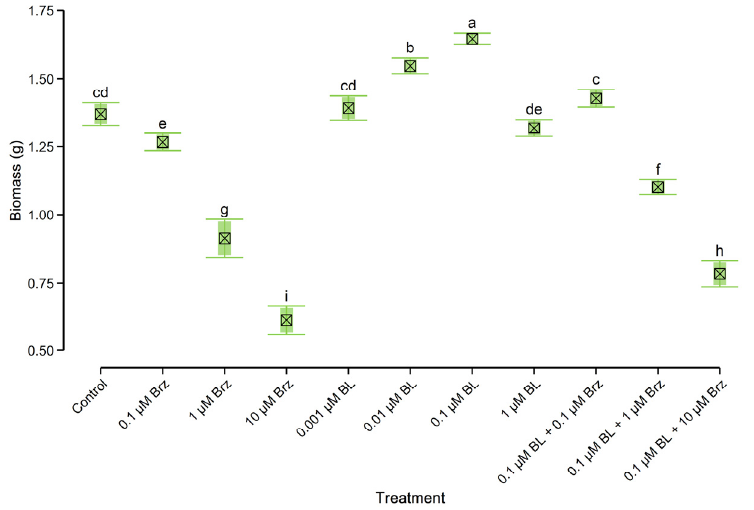
Figure 1. The effect of BL and/or Brz on W. arrhiza biomass after 7 days of cultivation. The crossed square shows the mean ( n = 5). The lower and upper hinges correspond to the lower and upper bounds of 95% confidence interval of the mean. The lower and upper whiskers extend from the hinge to mean ± standard deviation. Means with the same letters are not significantly different ( p ≥ 0.05) according to Tukey’s post-hoc test.